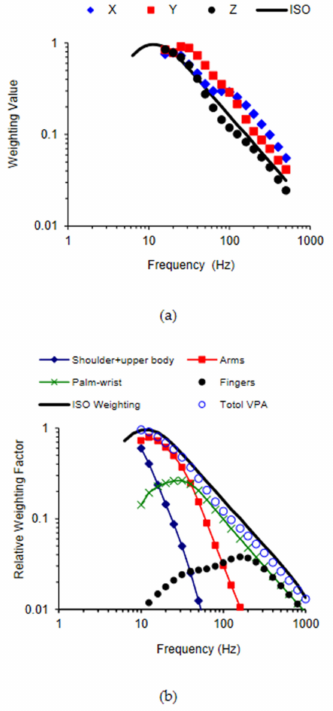
Figure 7. Comparisons of the VPA and standard frequency weightings: ( a ) the total VPA weightings in three orthogonal directions (X, Y, and Z in the forearm-based hand coordinate system shown in Figure 3) [36]; and ( b ) the relationships among the total VPA and the VPAs in the major substructures of the hand–arm system along the forearm direction ( z -axis)